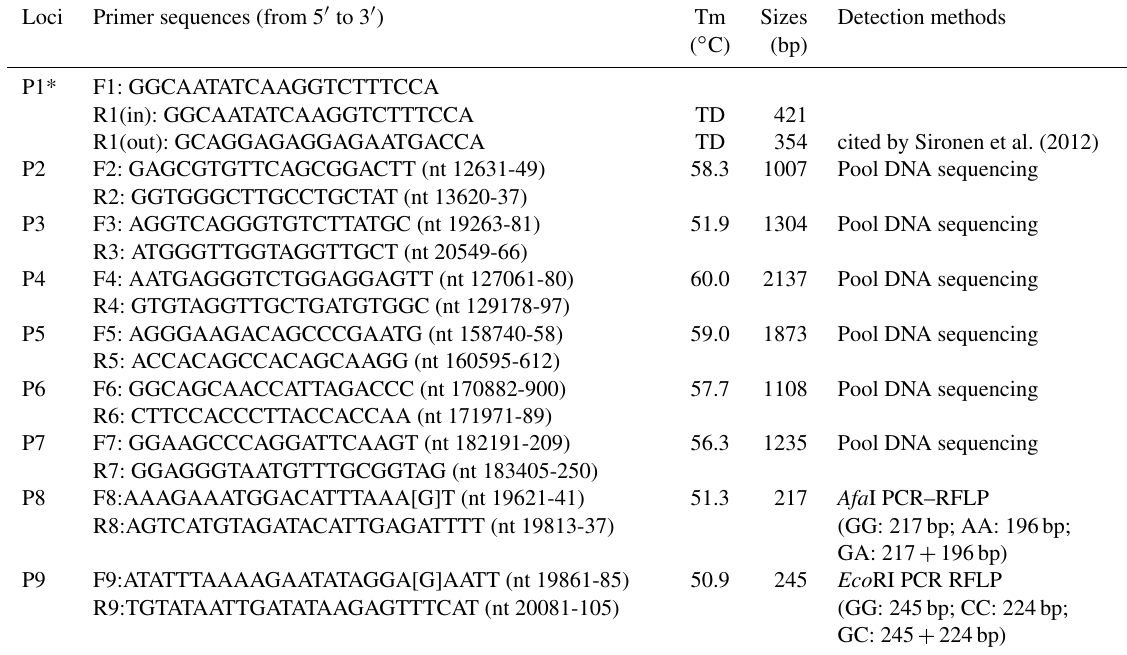
Table 1. PCR primer sequences of the pig SPEF2 gene for amplification.